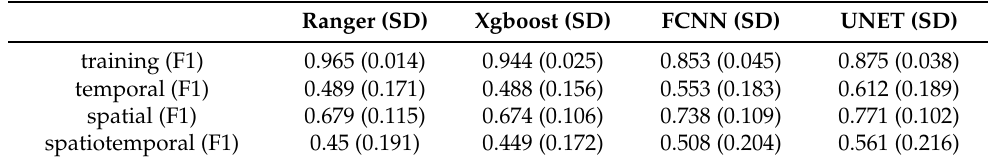
Table 4. Summary Spatiotemporal Generalization—F1.